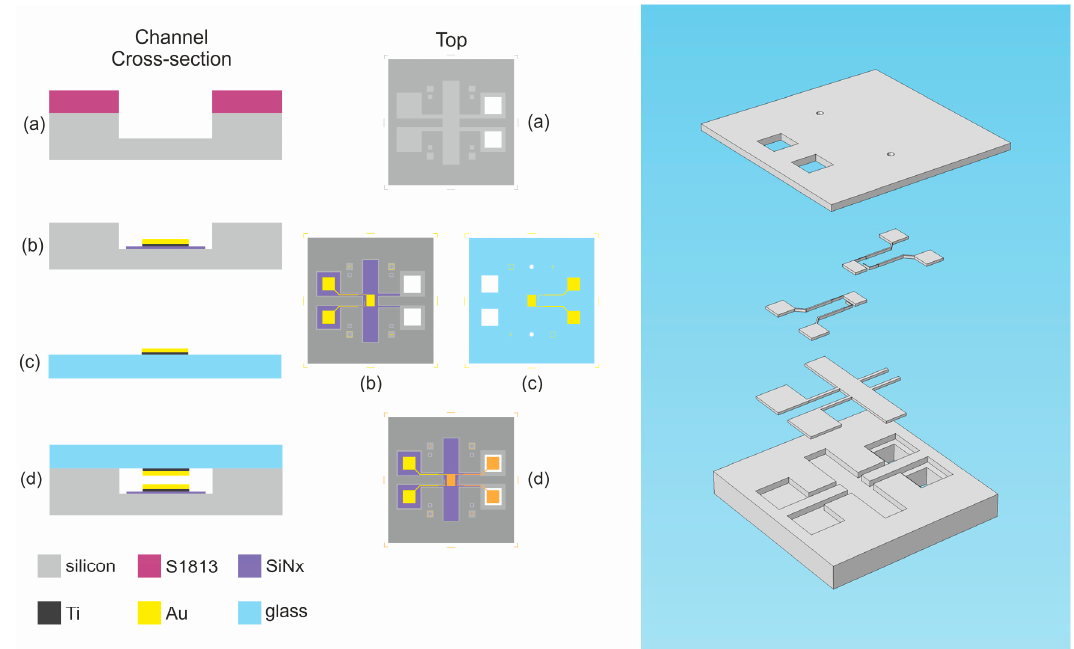
Figure 5. Left: Sequence diagram showing the channel central cross-section and top views of device after: ( a ) anisotropic dry etching of silicon to create a channel using a S1813 mask; ( b ) patterning of silicon nitride (SiN x ) passivation layer and lower electrode on silicon; ( c ) patterning the upper electrode on glass; and ( d ) anodic bonding. Right: Exploded 3D diagram showing the different layers of the completed device.